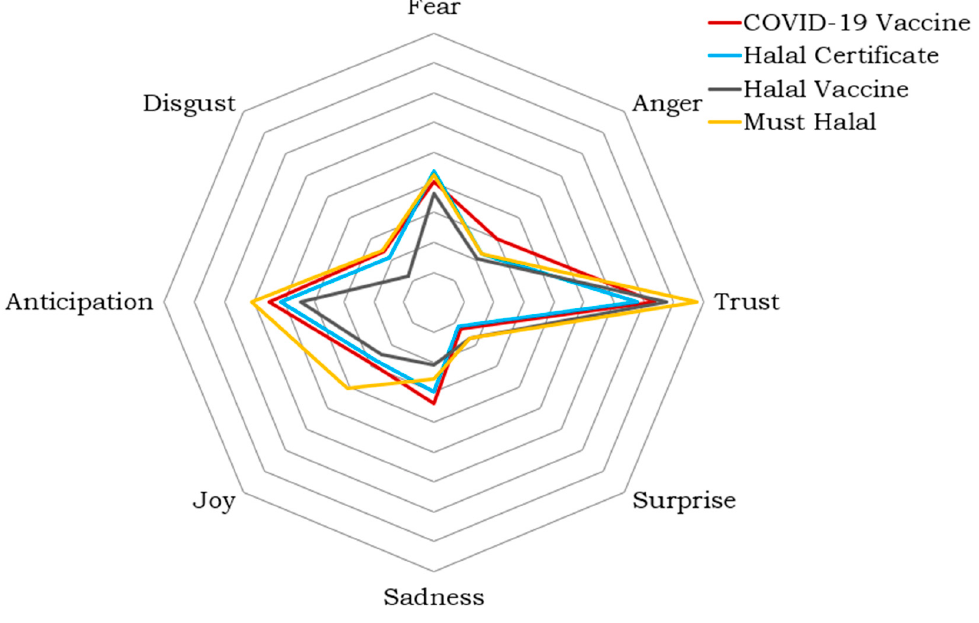
Figure 9. Emotion analysis for Twitter